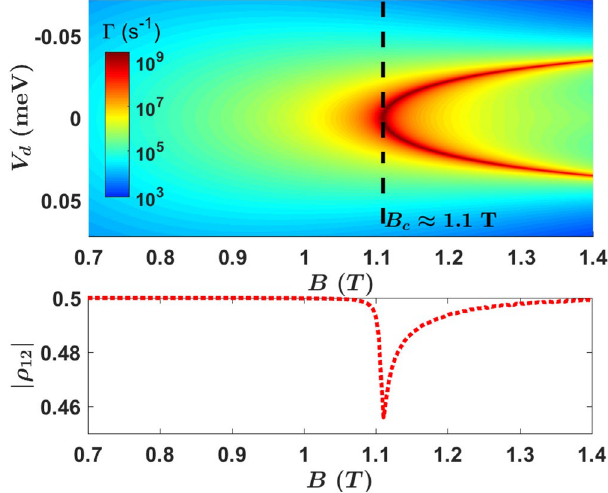
Figure 4. Upper panel: Spin relaxation rate as a function of the applied electric and magnetic field. Interdot detuning V d = 2 eEd with d = 48 nm. Lower panel: The actual residue coherence after the transport in 1